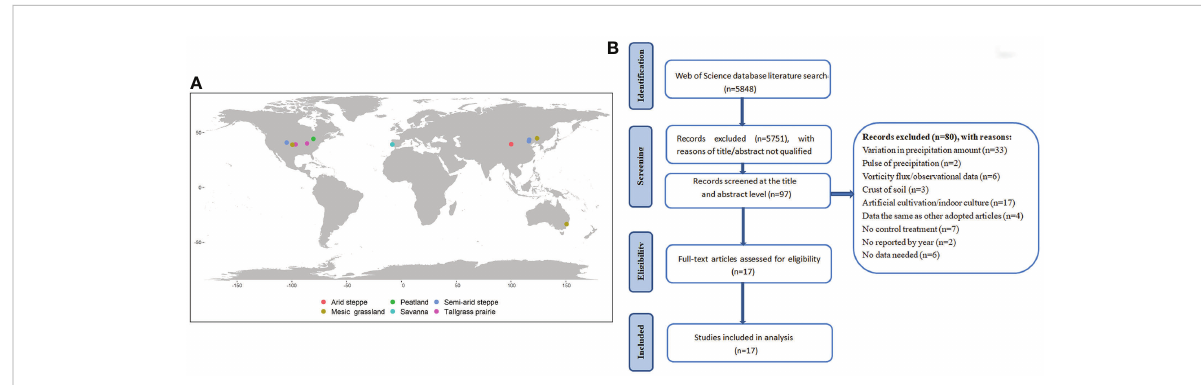
FIGURE 1 Map of the global distribution of study sites (A) and a fl ow chart of criteria for study selection (B) used in this meta-analysis. The distribution of 17 studies in 19 different